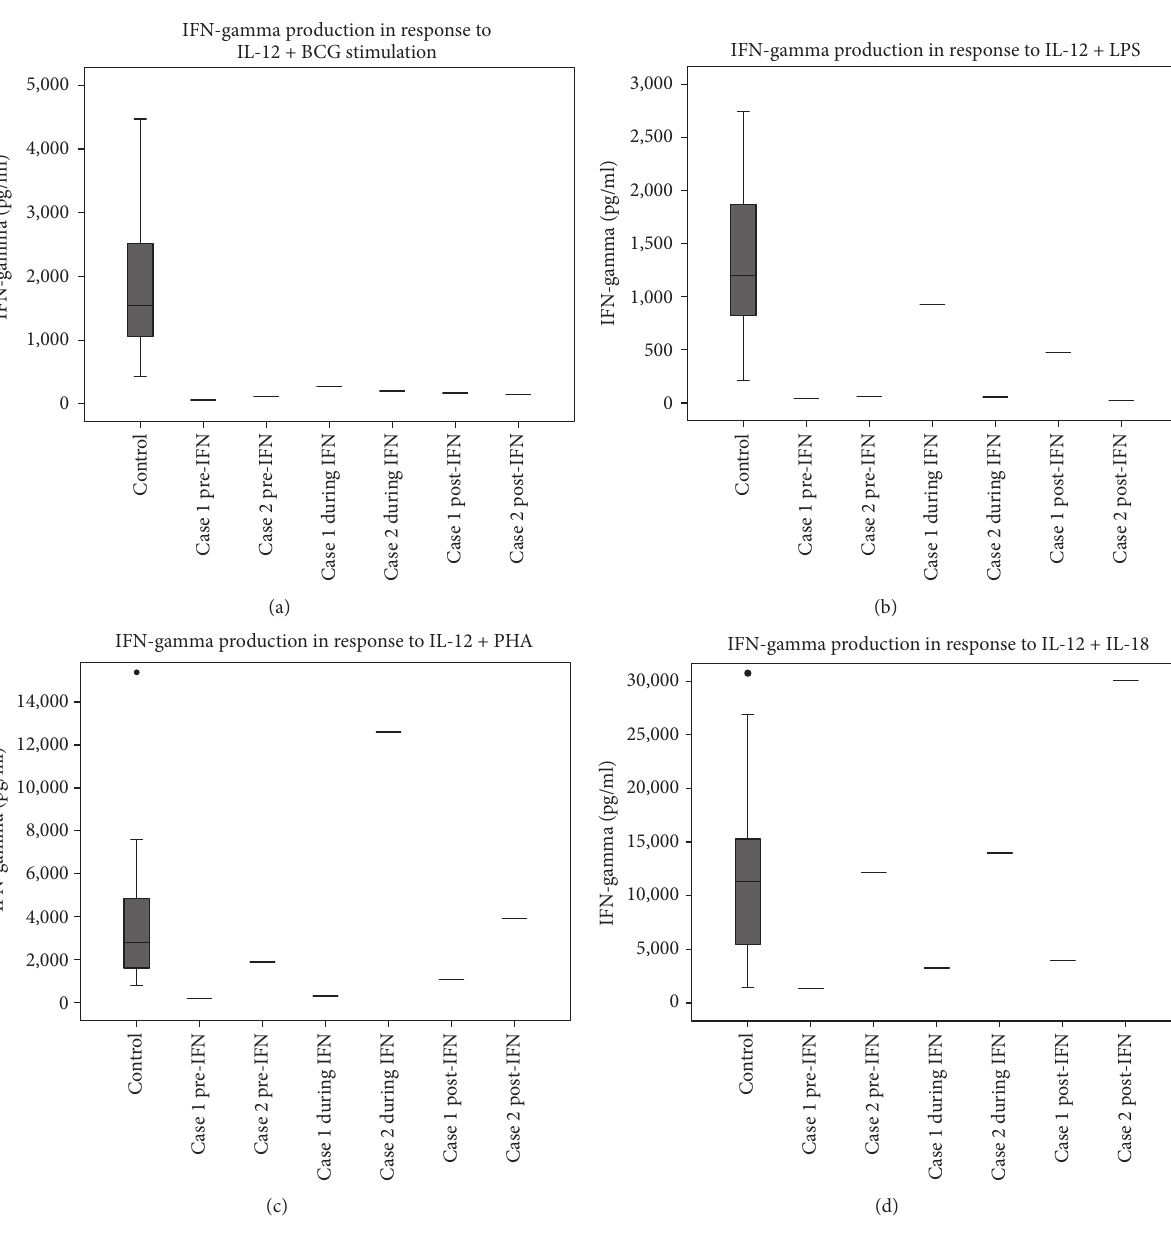
cyte count with a mild reduction of CD3+CD8+ T-cells, a